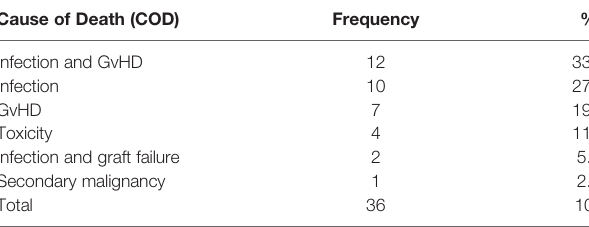
TABLE 2 | Cause of death compounded as